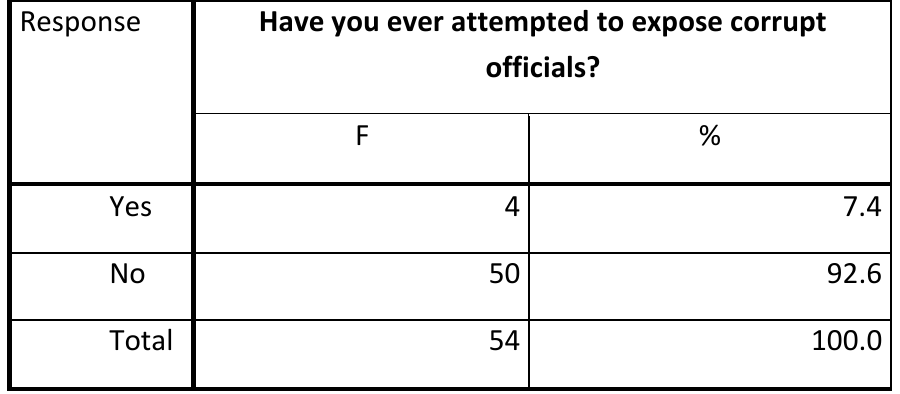
Table 18: Have you ever attempted to expose corrupt officials